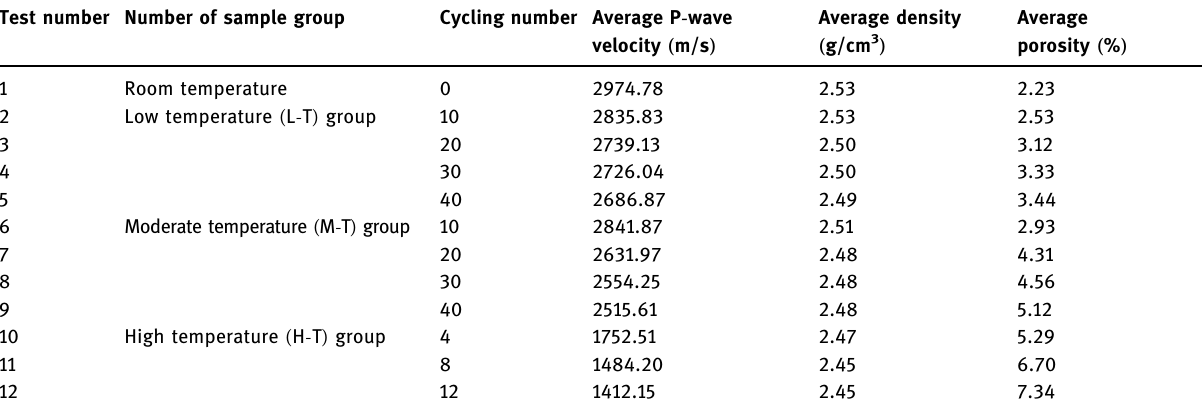
Table 1: Test results on the basic physical properties of sandstone after H – C cycles Test number Number of sample group Cycling number Average P - wave